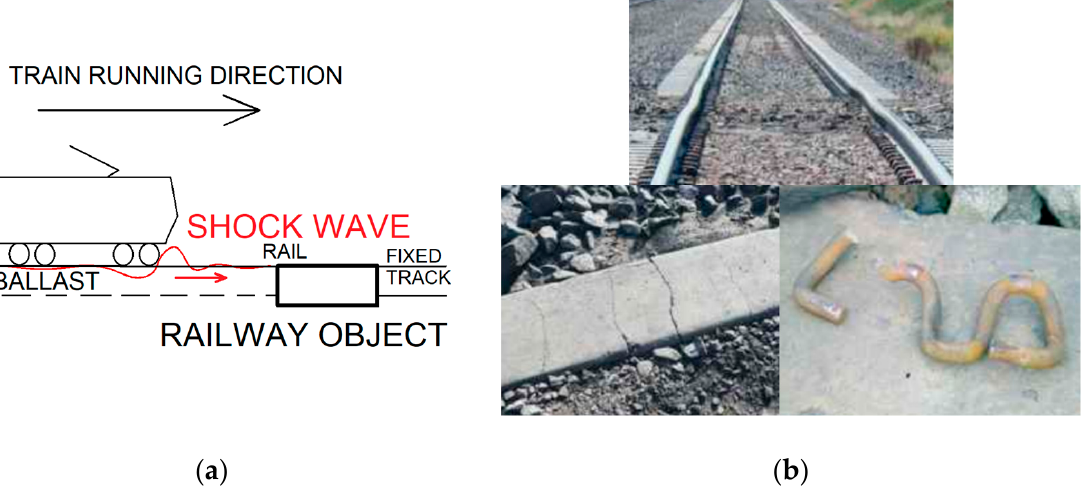
Figure 3. Shock wave caused by a train running: ( a ) Shock wave on all fixed railway objects [13]; ( b ) Photo: Deformation of geometric position and heights [2].